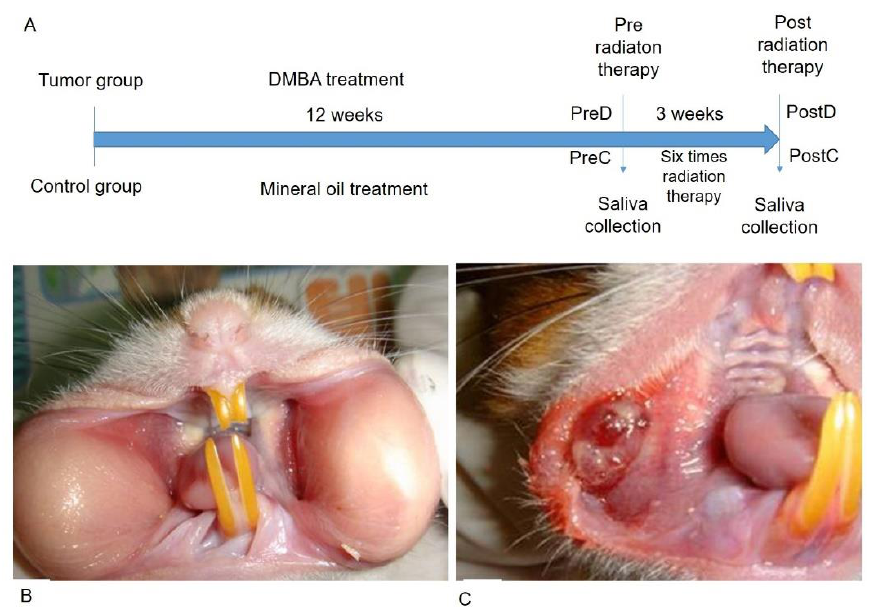
Figure 1. DMBA-induced tumor mass in the buccal pouch of the golden hamster. ( A ): Time frame of the research design; ( B ): Normal buccal pouch; ( C ): DMBA-induced tumor in buccal pouch.